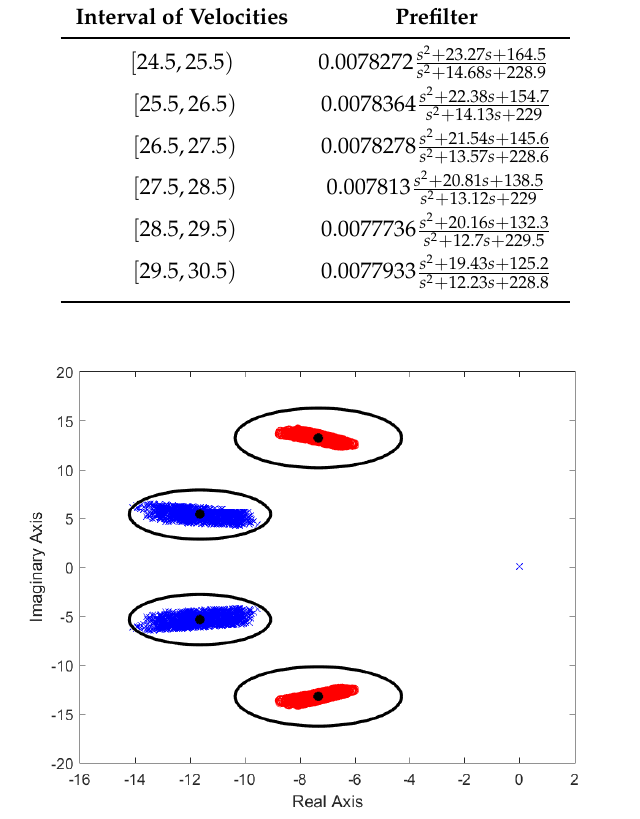
Figure 12. Pole-zero map for a randomly generated parametric sweep of the vehicle model.